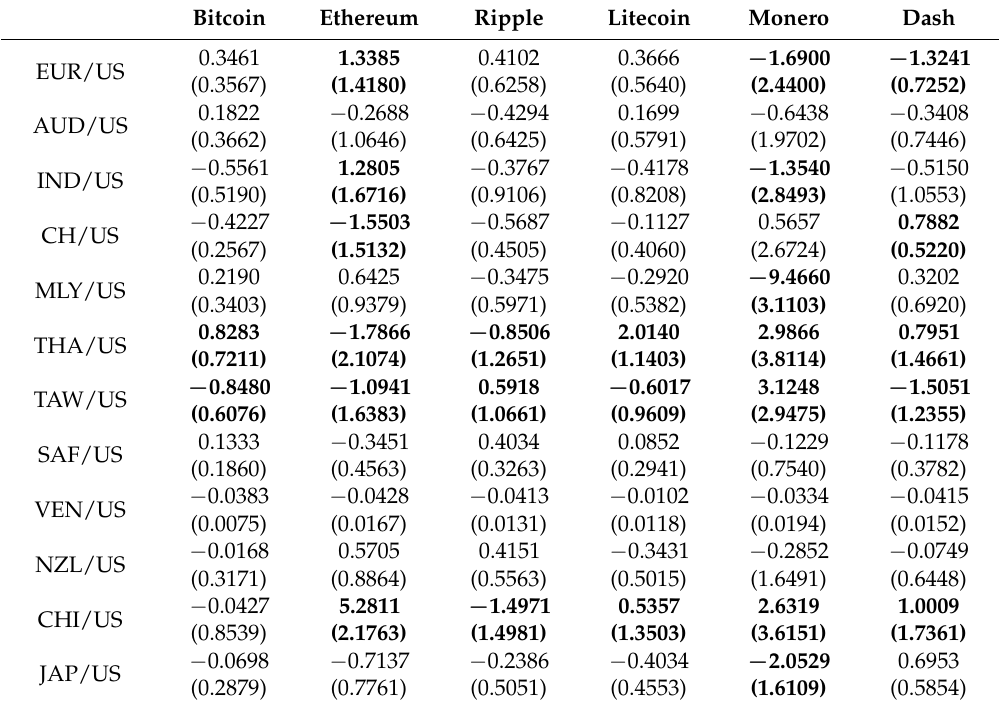
Table 3. Results of the multivariate regression of each cryptocurrency against the fiat currencies (significant coefficients are in bold, with significance in